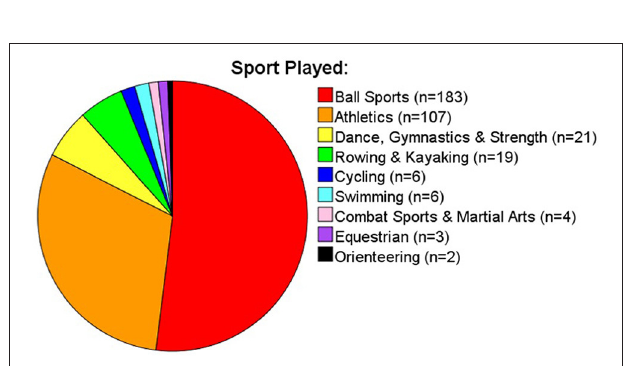
FIGURE 2 | Pie chart of sports played by the athlete sample.